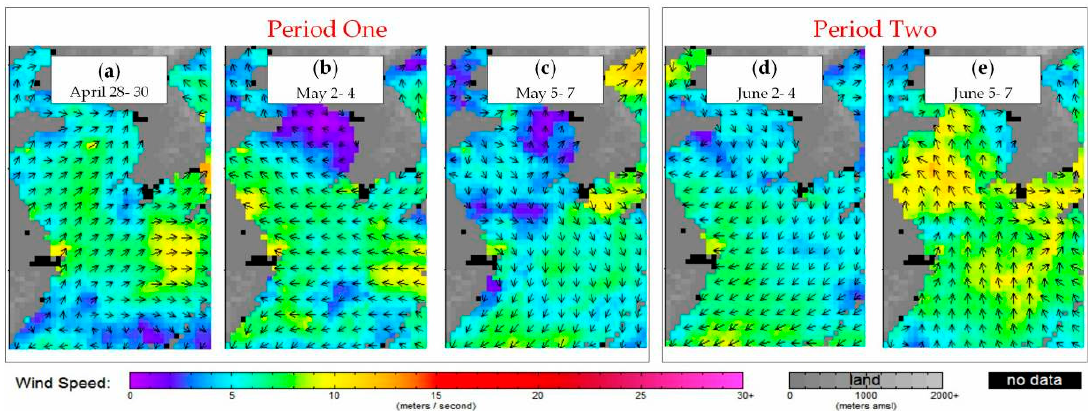
Figure 17. Three-day average surface wind speed and direction of oblateness change periods in 2017, obtained from RSS. ( a – c ) The change of SSW in period one. ( d , e ) The change of SSW in period two.